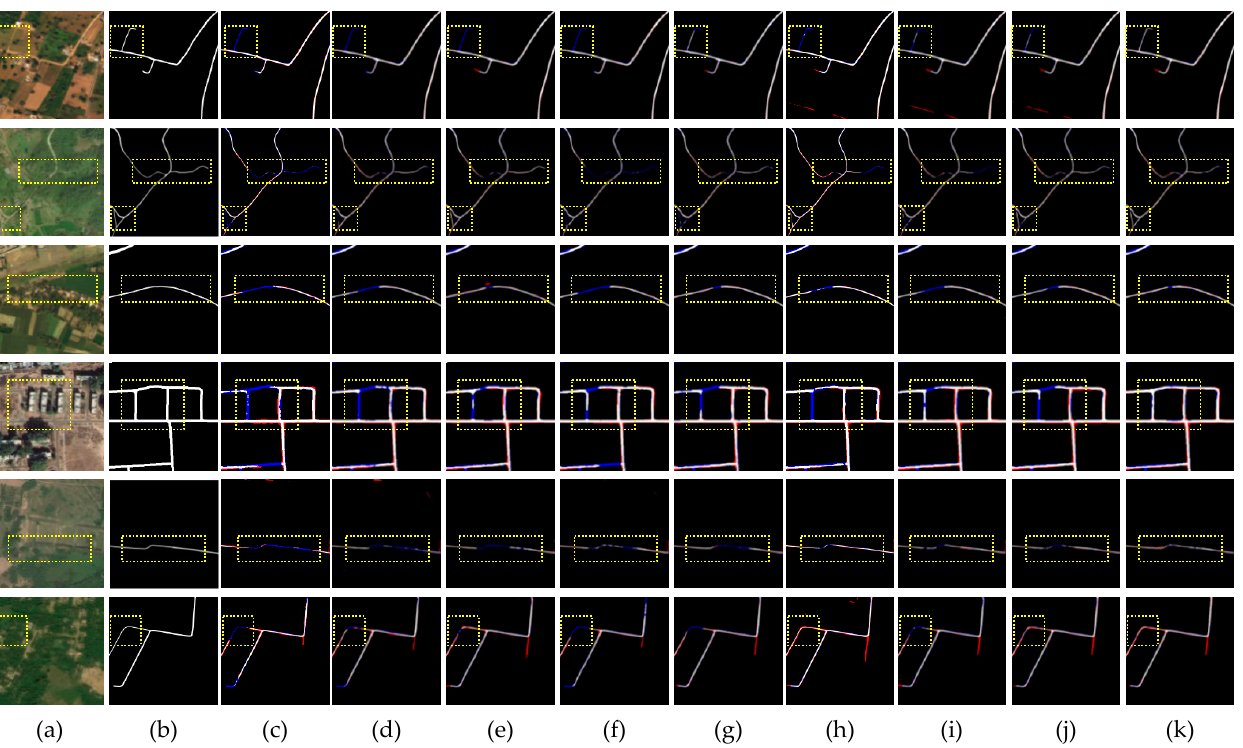
Figure 6. Comparison of visualization results between MECA-Net and other road extraction methods on the DeepGlobe dataset. ( a ) Image; ( b ) Label; ( c ) RoadNet results; ( d ) SegNet results; ( e ) NL-LinkNet results; ( f ) UNet results; ( g ) DeepLabv3+ results; ( h ) PP-LinkNet results; ( i ) LinkNet results; ( j ) D-LinkNet results; ( k ) MECA-Net results. White: true positive. Black: true negative. Blue: false negative. Red: false positive.